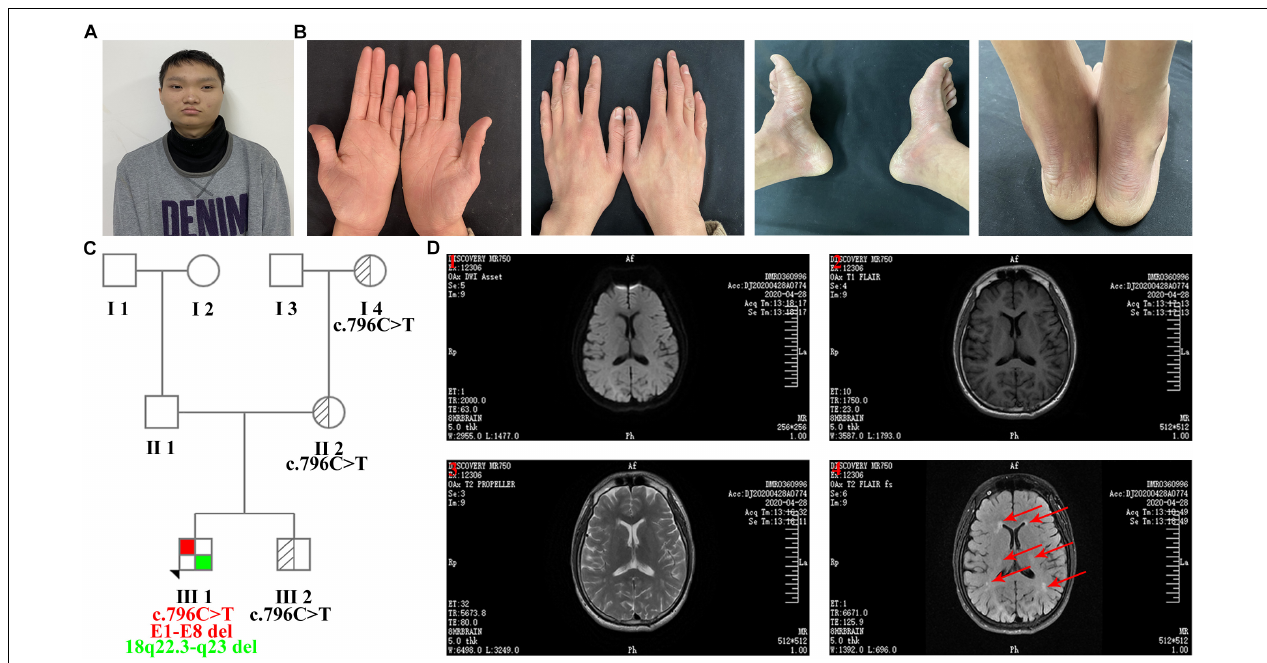
FIGURE 1 | Clinical features of the proband. (A) Facial features: wide-set eyes and short philtrum. (B) Bilateral erythema and hyperkeratosis of the hands and feet. (C) Family tree (E1-E8 del: exon 1-exon 8 deletion). (D) MRI images of transverse views. (1) Diffusion-weighted imaging (DWI); (2) T1 weighted image (T1WI); (3) T2 weighted image (T2WI); (4) Water image. MRI images indicated that the proband had multiple abnormal signals in the bilateral frontal and parietal lobes, and red arrows represent the regions of brain white matter